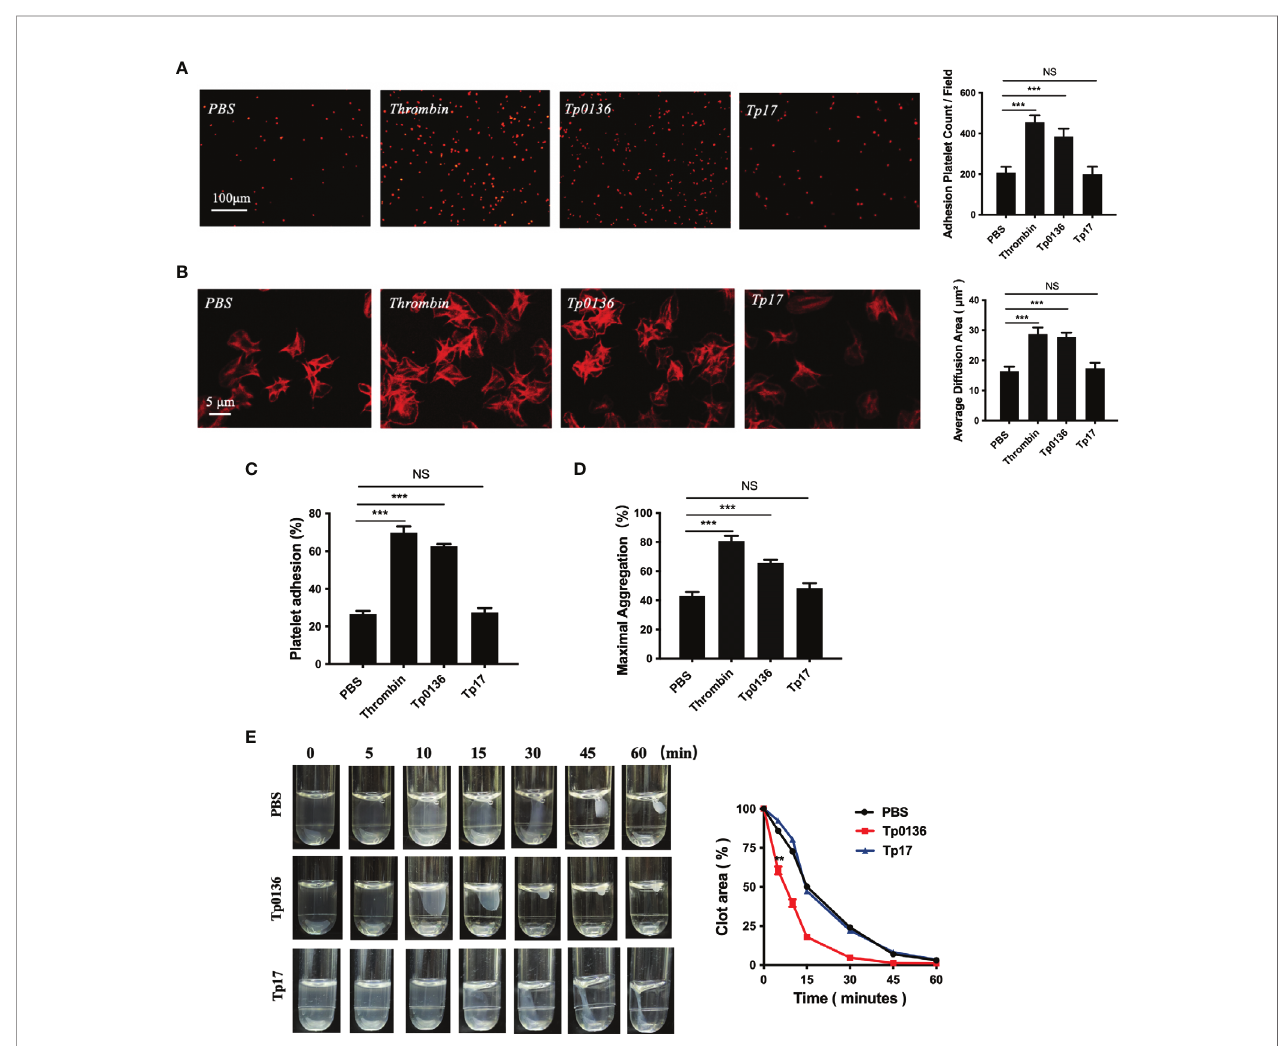
FIGURE 1 | Tp0136 promoted human platelet adhesion and aggregation. (A, B) Effect of Tp0136 on platelet adhesion as determined by staining with TRITC-labeled phalloidin. Statistical data were determined based on the number of platelet adhesions (A) and were calculated from the mean of the average surface area of individual platelets (B) . (C) Platelet adhesion as assessed by ELISA. (D) The maximum aggregation rate of platelets was determined by an aggregometer. (E) Platelet clot retraction was quanti fi ed by the ratio of the clot area to the platelet suspension area at different time points. The values are presented as the mean ± SEM of experimental triplicates and are representative of the results of three independent experiments. Values among multiple groups were compared by one-way ANOVA. Comparisons between two groups in the platelet clot retraction experiment were made using a paired t-test (NS, no signi fi cance, ** P < 0.01, *** P <